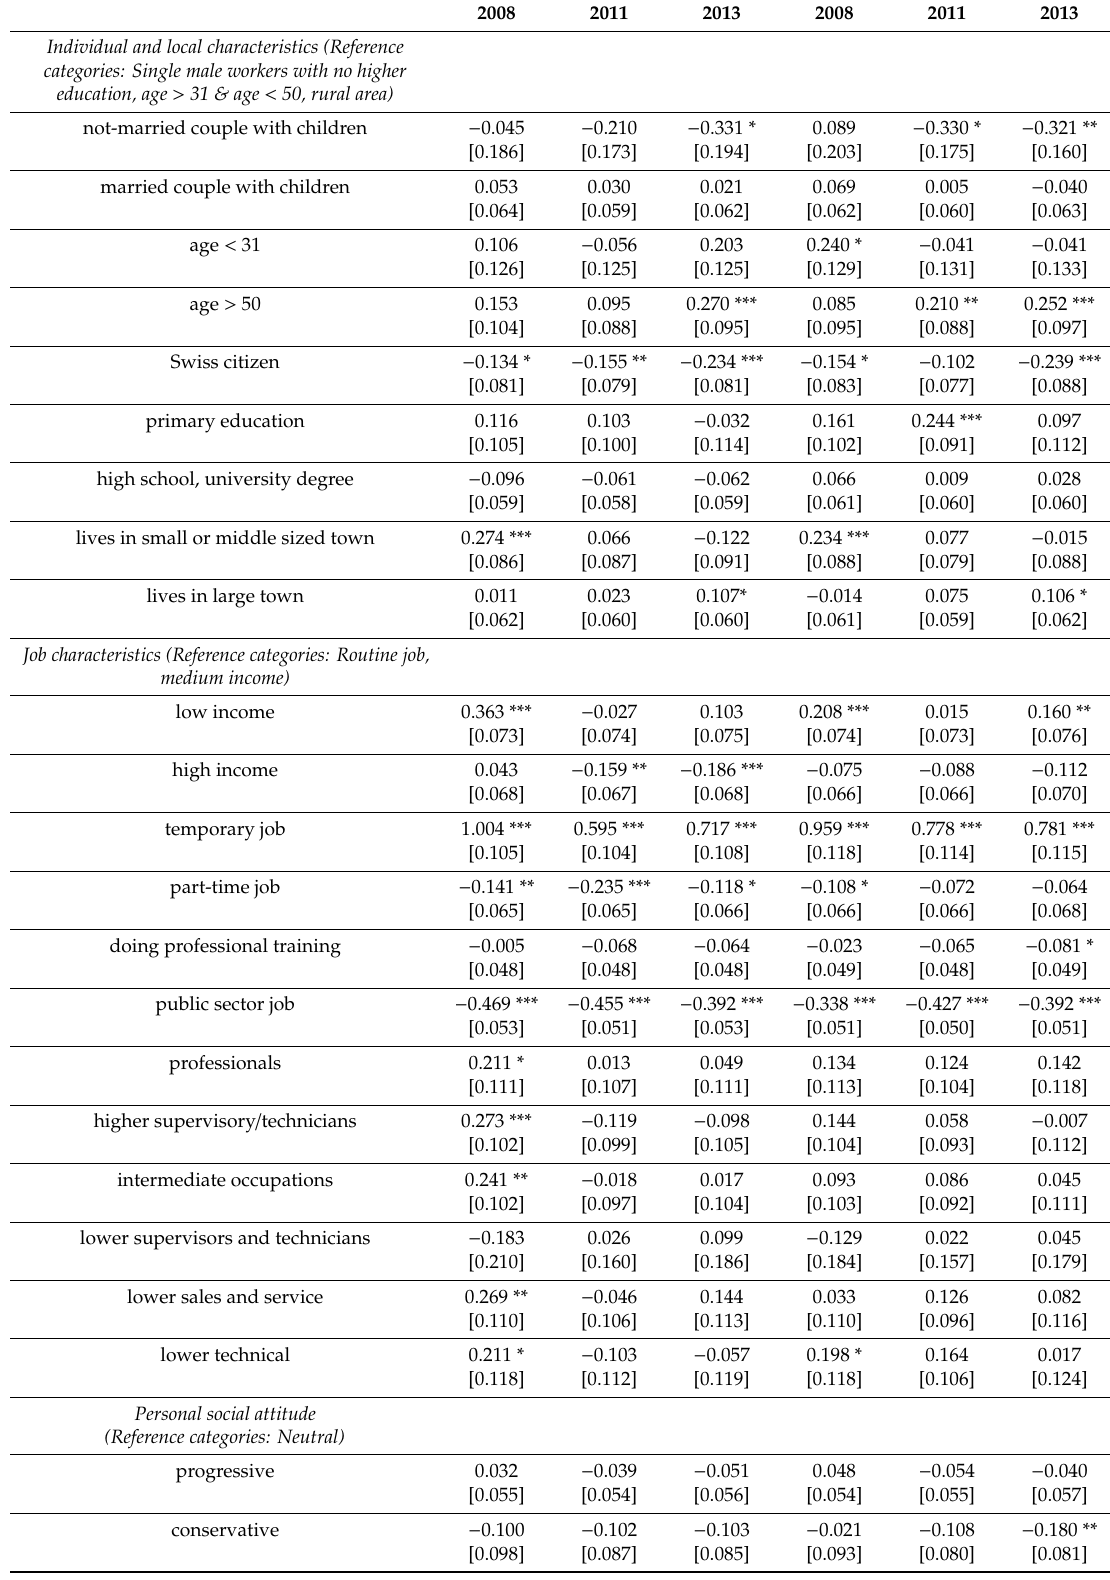
Concerned about Job Security ( job ins